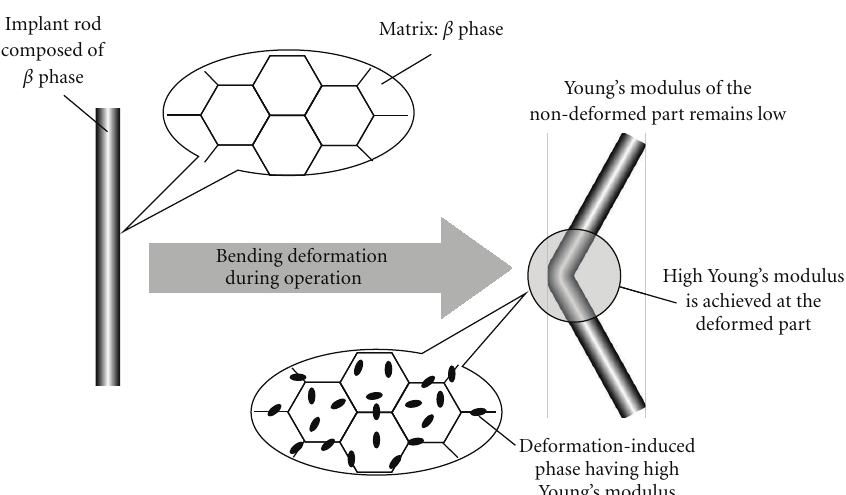
Figure 12: Concept of self-adjustment of Young’s modulus in implant rod. If Young’s modulus of the deformation-induced phase is higher than that of the matrix, Young’s modulus of only the deformed part is increased by bending during operation, whereas that of the nondeformed part remains low; thus, the requirements of both surgeons and patients can be satisfied. High Young’s modulus suppresses the spring back of the implant rod, whereas low Young’s modulus inhibits the stress shielding e ff ect, thereby enabling good handling ability of implant rod and remodelling of healthy bone, respectively.